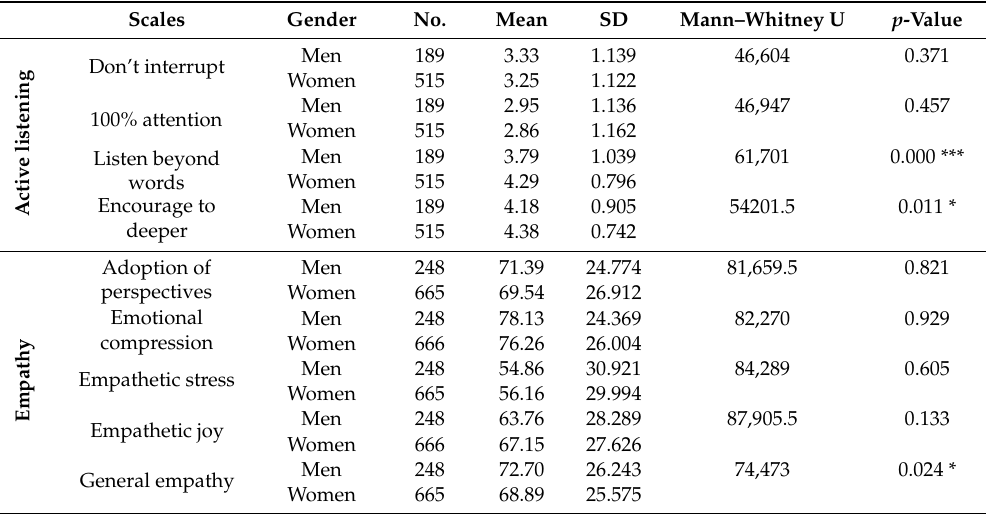
Table 2. Gender-based di ff erences in active listening and empathy. Scales Gender No.